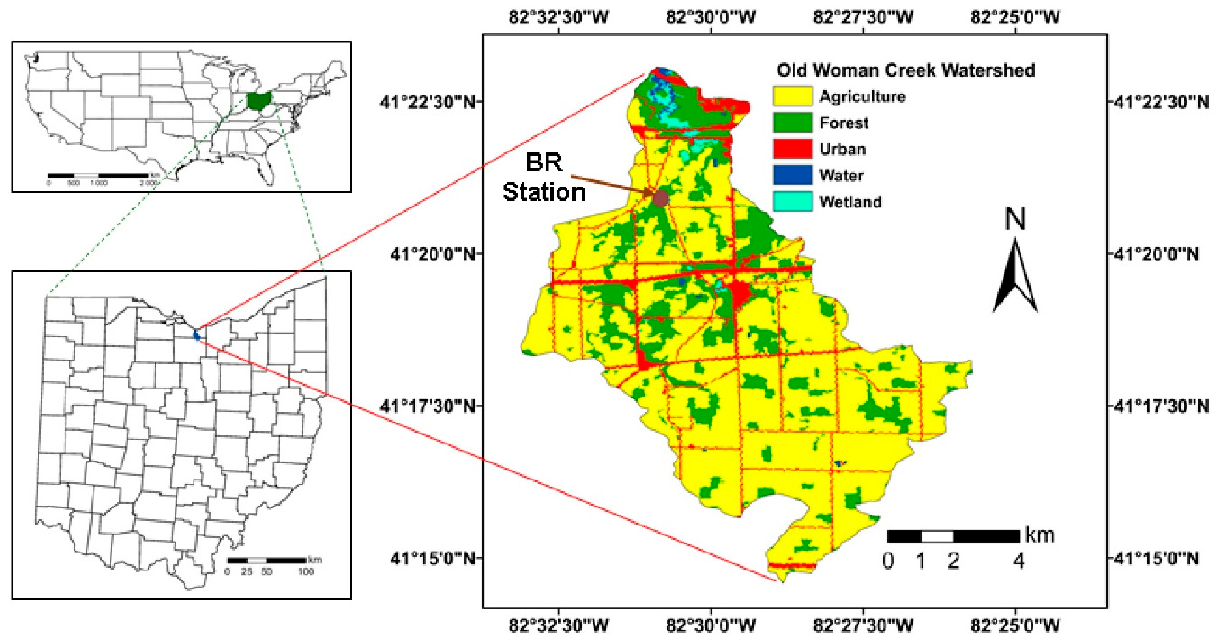
Figure 1. Location map of Old Woman Creek watershed.